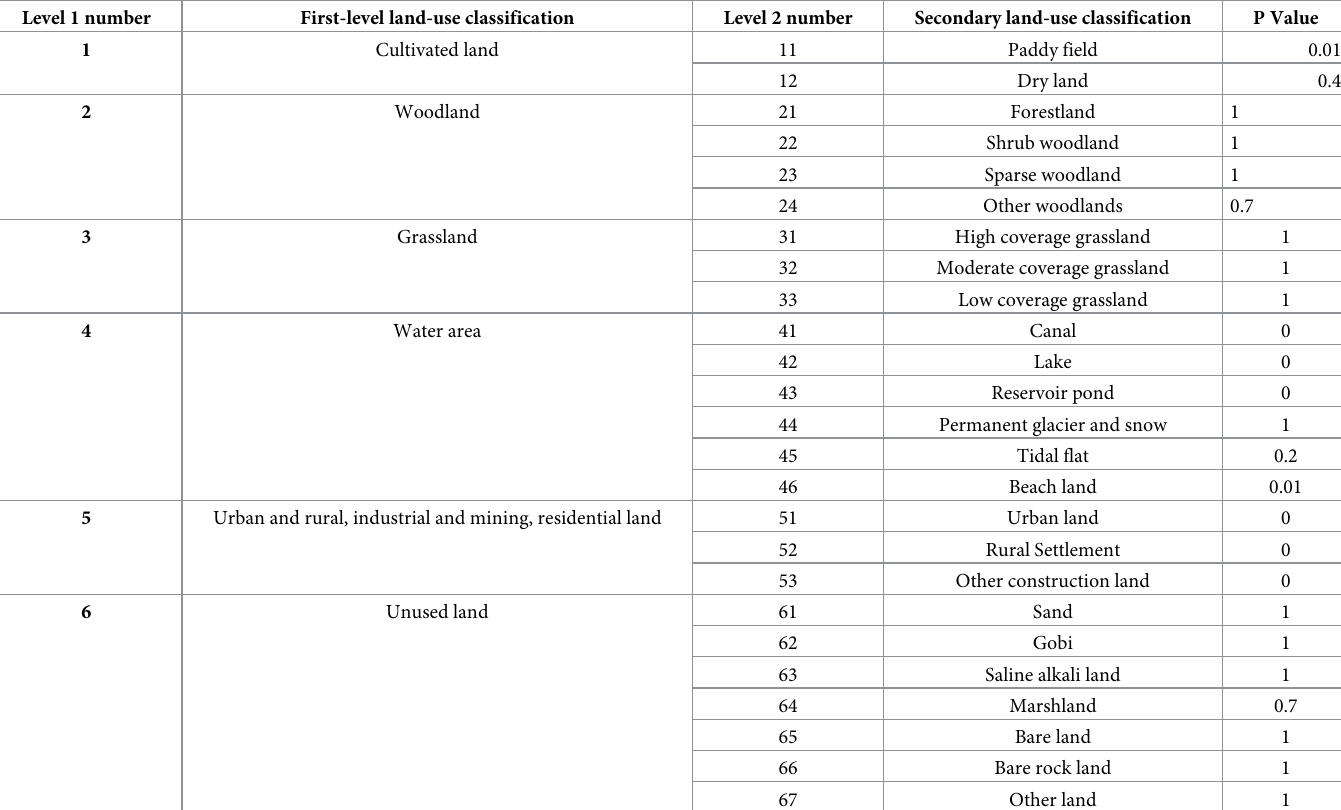
Table 2. Assignment of P values based on land use.